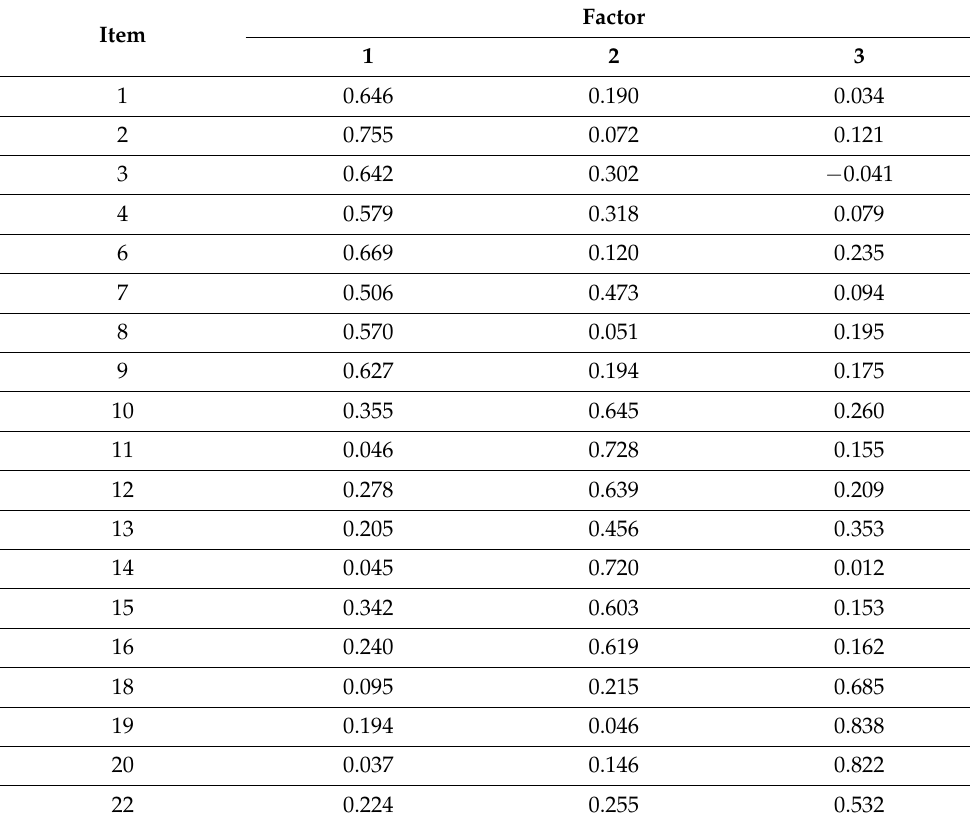
Table 3. Factor loadings for the three-factor